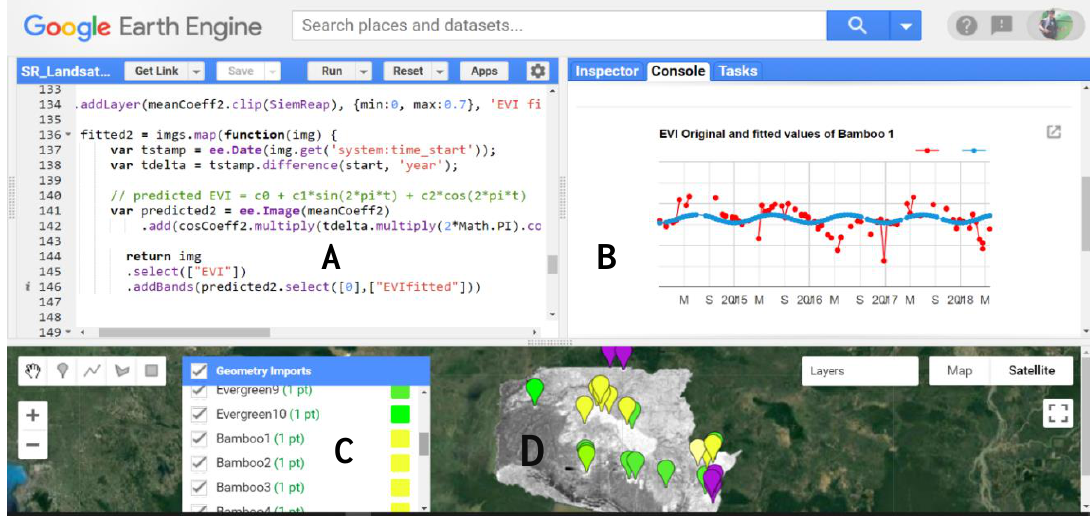
Figure 3. Example of original and fitted OLI index time-series profile of evergreen forest and bamboo between 2015 and 2018 generated by using harmonic regression and a time-series model. ( A ) is the GEE JavaScript code window, ( B ) is the EVI time-series graph, ( C ) is the geometry inputs for selected forest land cover categories and ( D ) shows the map window in GEE.